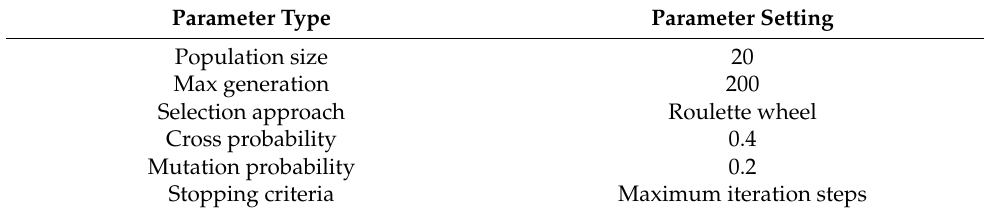
Figure 4. Flowchart of genetic-algorithm-enhanced extreme learning machine. Table 1. Setting parameters of genetic algorithm.